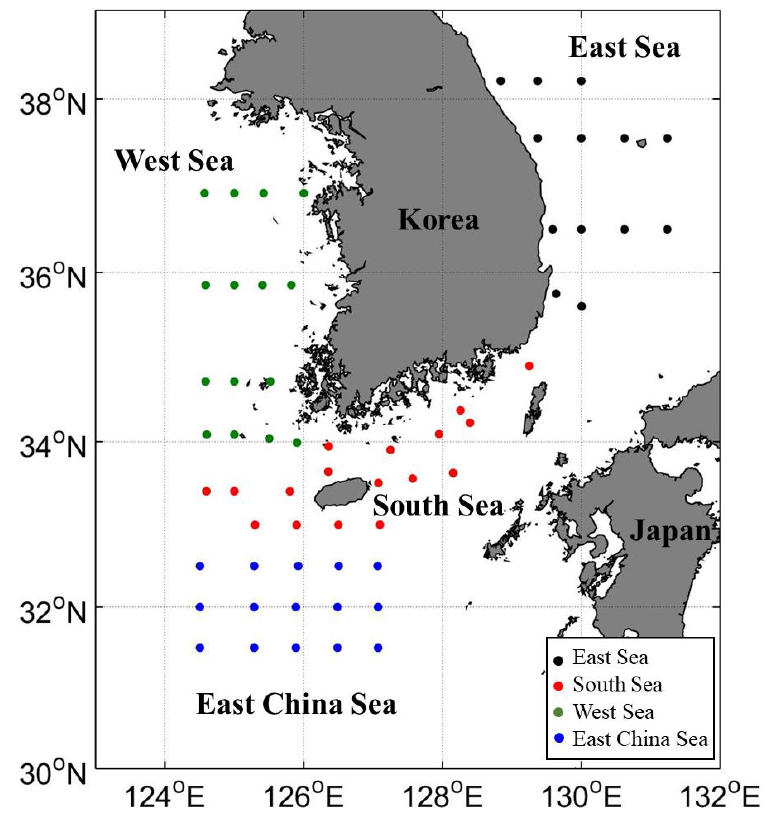
Figure 1. Locations of field observation stations.